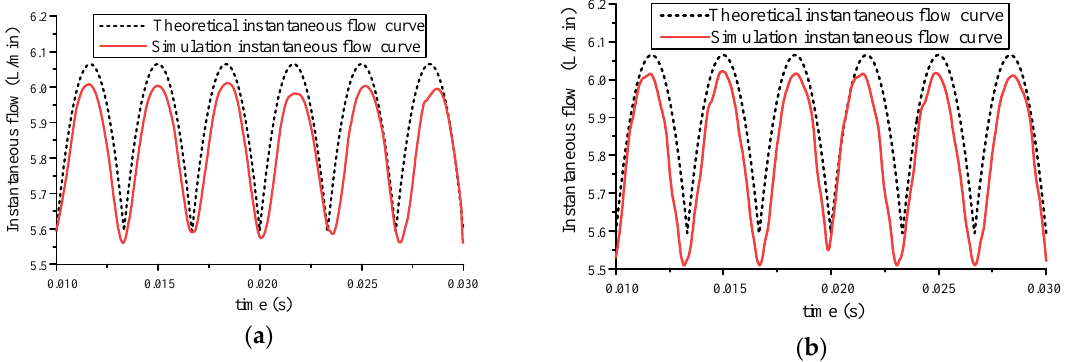
Figure 7. Comparison diagram of simulated instantaneous flow rate and theoretical instantaneous flow rate of gear pump outlet: ( a ) 2D model validation; ( b ) 3D model validation.